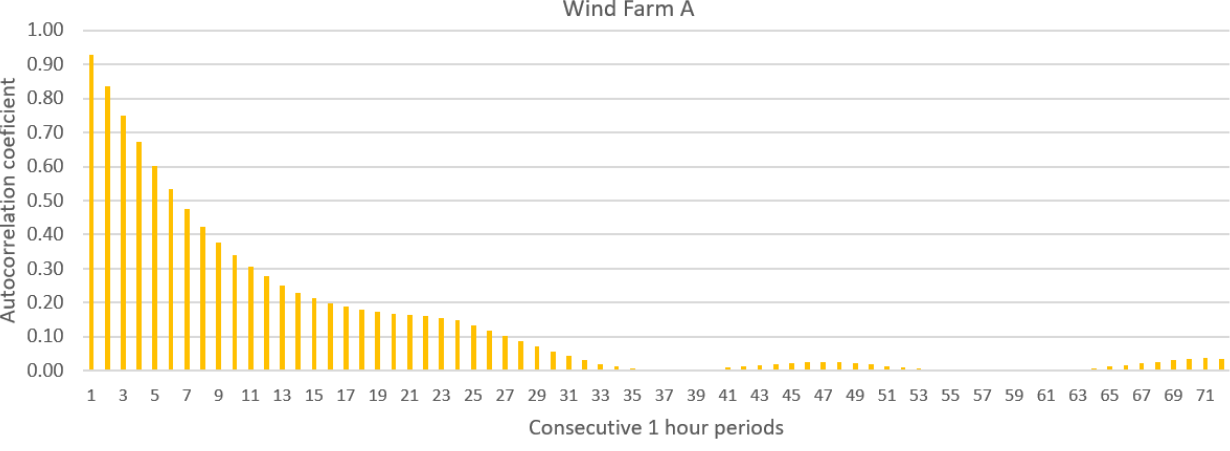
Figure 3. Autocorrelation function (ACF) of the Wind Farm B energy generation time series. Figure 4 shows daily variability of hourly energy production [p.u.] of Wind Farms A and B. Arithmetic means of hourly energy generations for each hour of the day were cal- culated based on data span from 4 April 2017 to 28 September 2018 (18 months in total), with omitting test period datetimes—1 October 2018 to 1 October 2019. For the same pe- riods, mean arithmetic hourly generations were calculated for each month, with the aver- aging of values for the months occurring two times. Pearson linear correlation coefficient between the data is equal to 0.950. Daily variability of electric energy generation of both wind farms is similar. Figure 5 shows seasonal variability of electrical energy generation of Wind Farms A and B. Pearson linear correlation coefficient between the data is equal to 0.922. Seasonal variability of electric energy generation of both wind farms is similar.